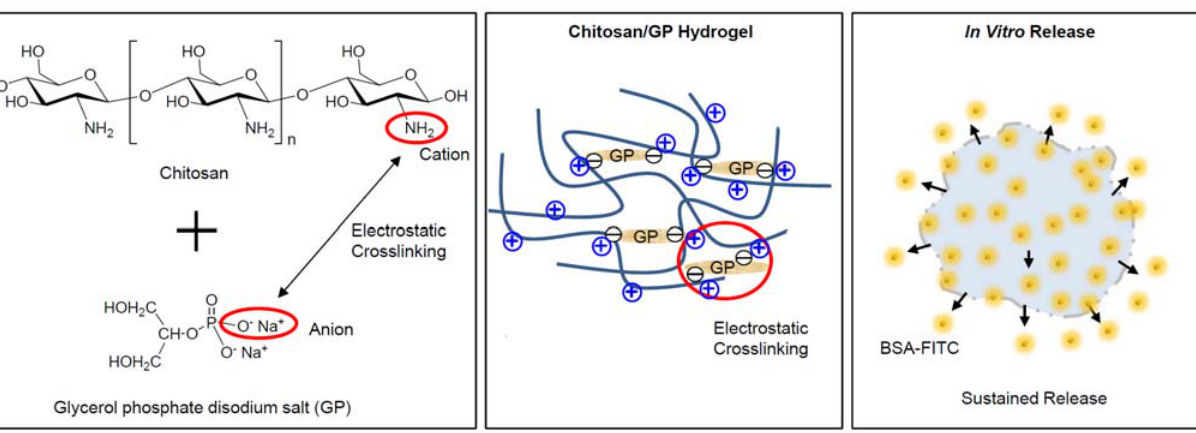
Figure 1. Schematic image of chitosan/GP hydrogel formation via electrostatic crosslinking between amine cationic groups of the chitosan chains and the phosphate anionic groups of the GP, and in vitro release of BSA-FITC from BSA-FITC-loaded chitosan/GP